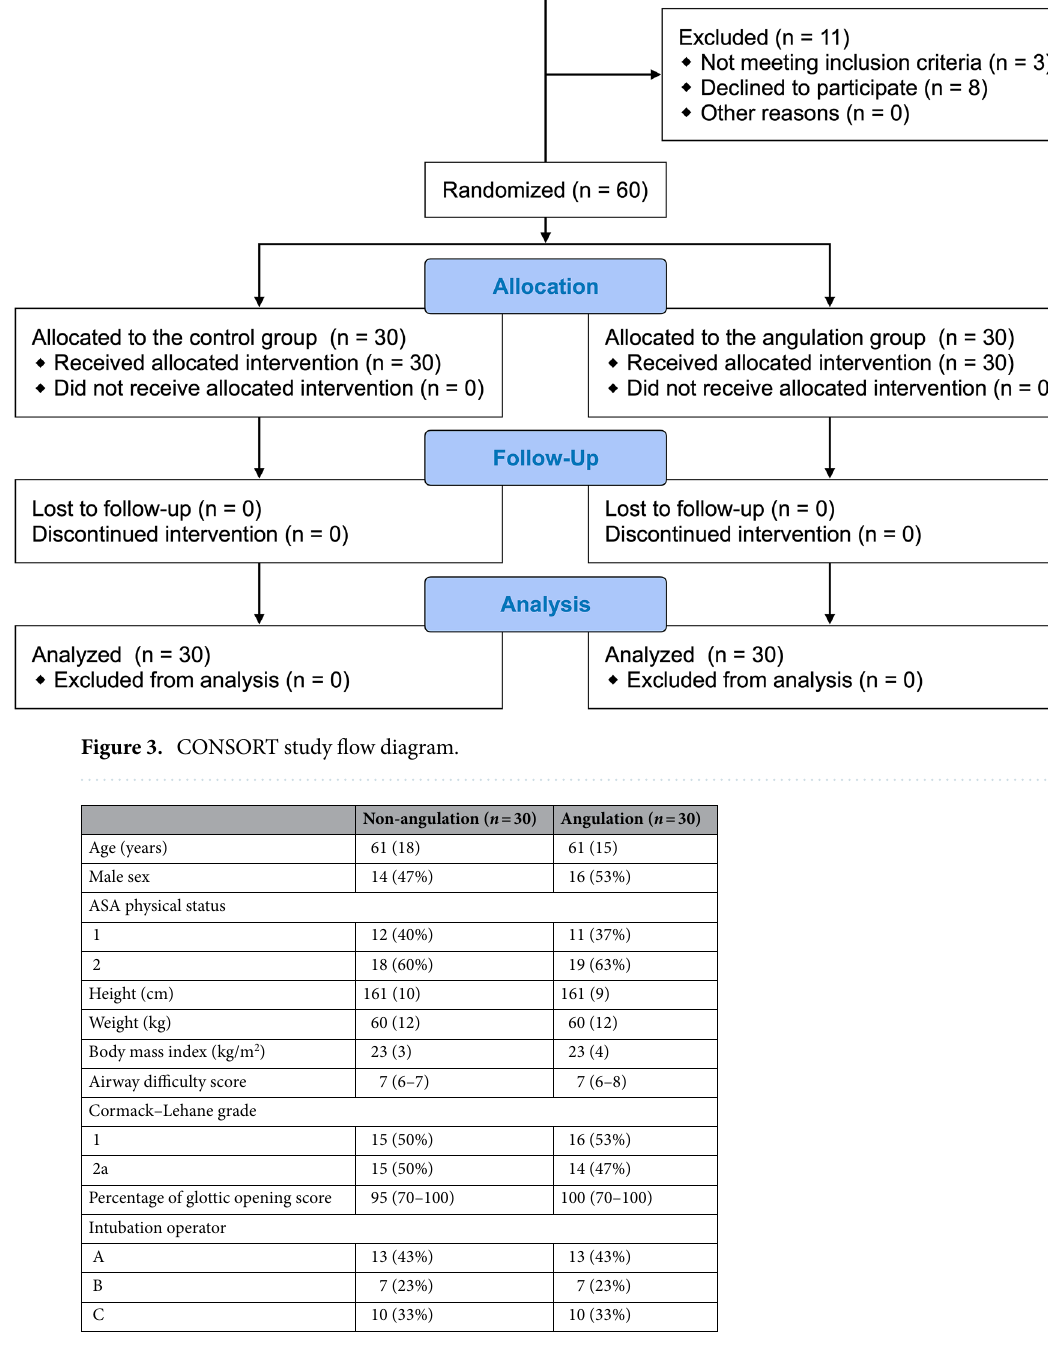
Table 1. Baseline and airway characteristics of study patients. Data are expressed as mean (standard deviation), number (proportion), or median (interquartile range). ASA American Society of